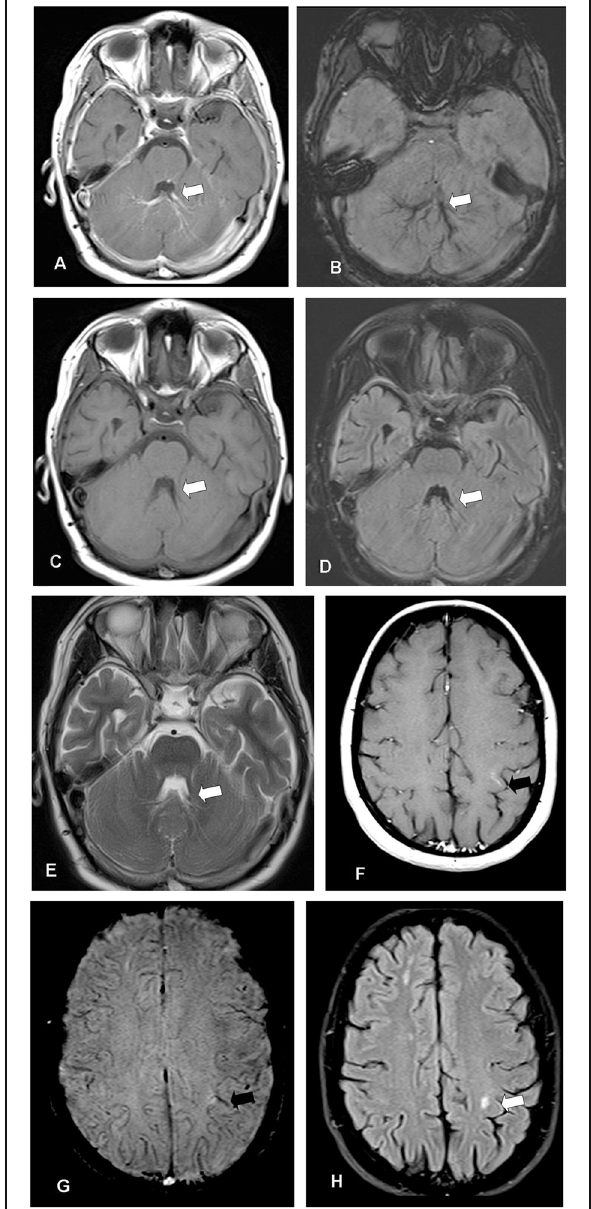
Fig. 4 Contrast-enhanced T1W ( a ) and SWI ( b ) show large cerebellar DVA (white arrow). On non-contrast T1W ( c ), FLAIR ( d ), and T2W ( e ), the lesion is less clearly visible (white arrow). The same patient shows coexistent supra-tentorial left posterior parietal smaller DVA (black arrow) seen on post-contrast T1 ( f ) and SWI ( g ) with associated parenchymal hyperintense signal on FLAIR ( h ). Other nonspecific white matter small ischemic foci seen at the right frontal lobe with no associated gross vascular anomalies ( h